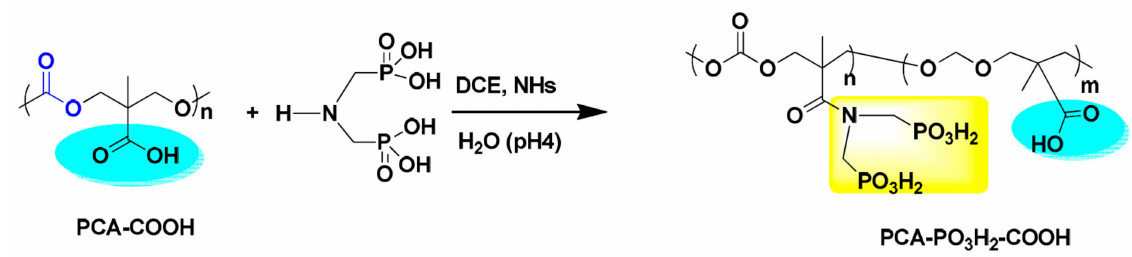
Figure 6. Functionalization of PCA-COOH with phosphonate groups to PCA-PO 3 H 2 -COOH [109].